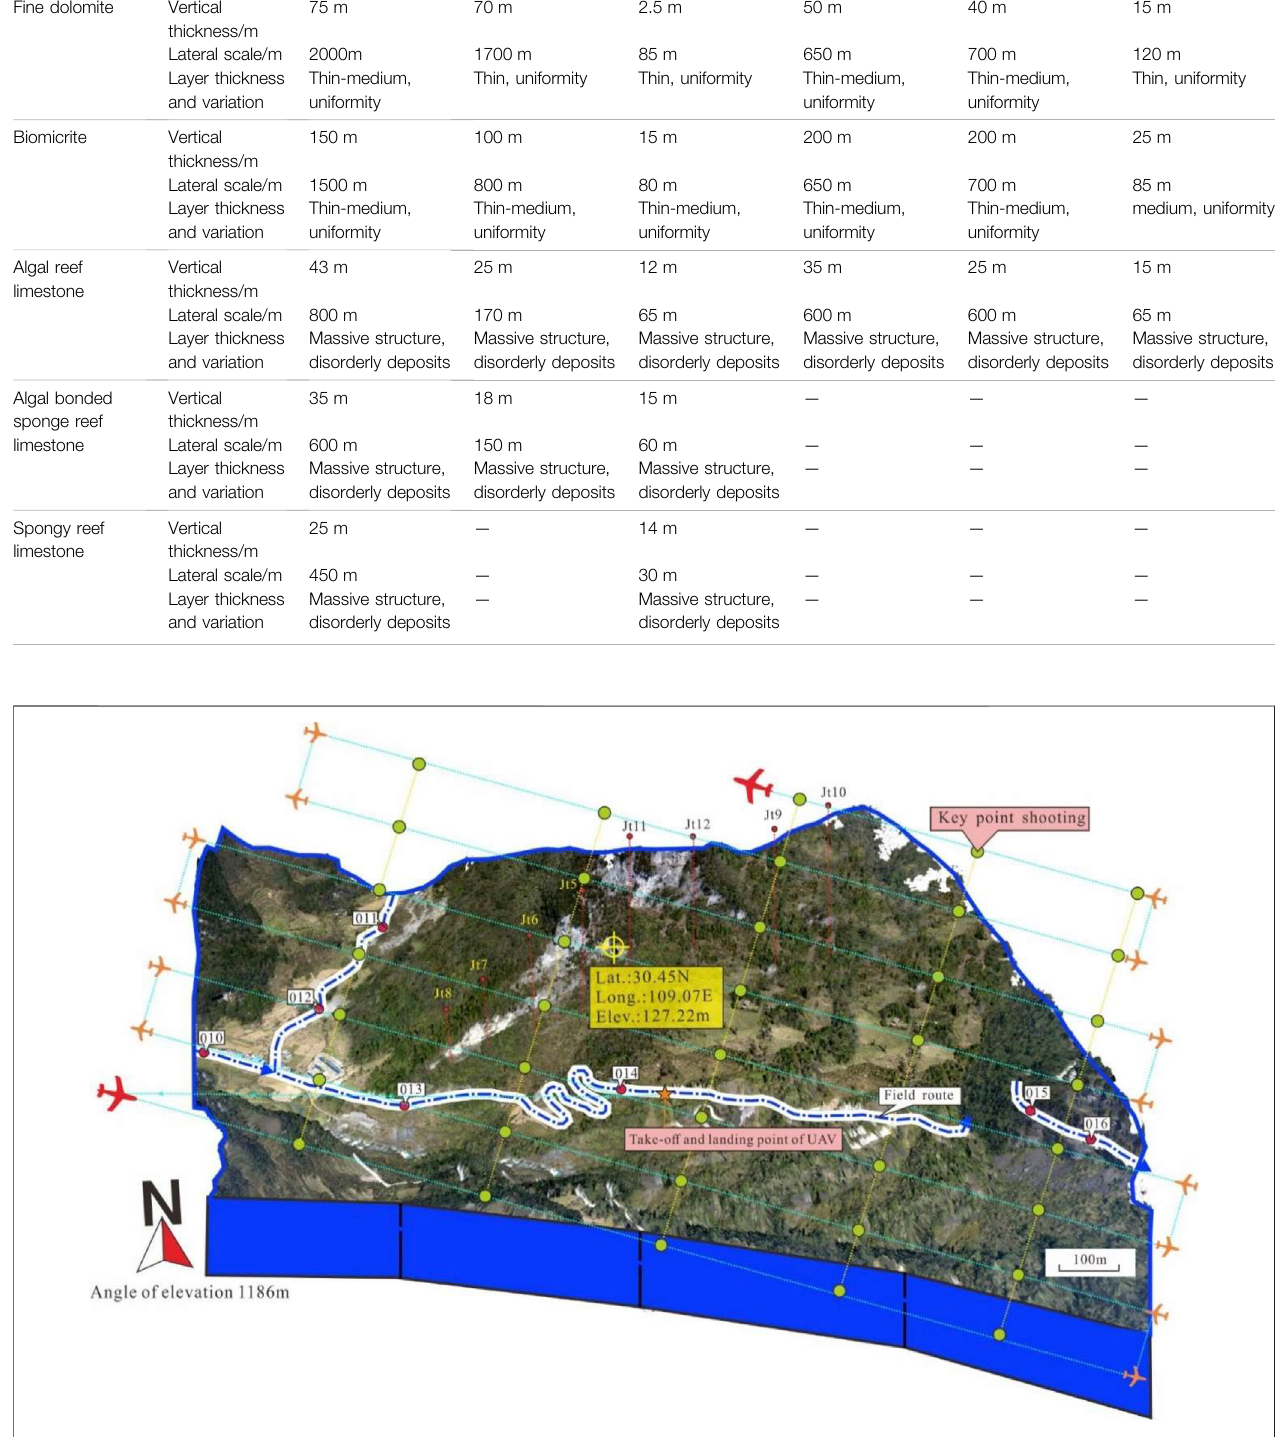
Frontiers in Earth Science |